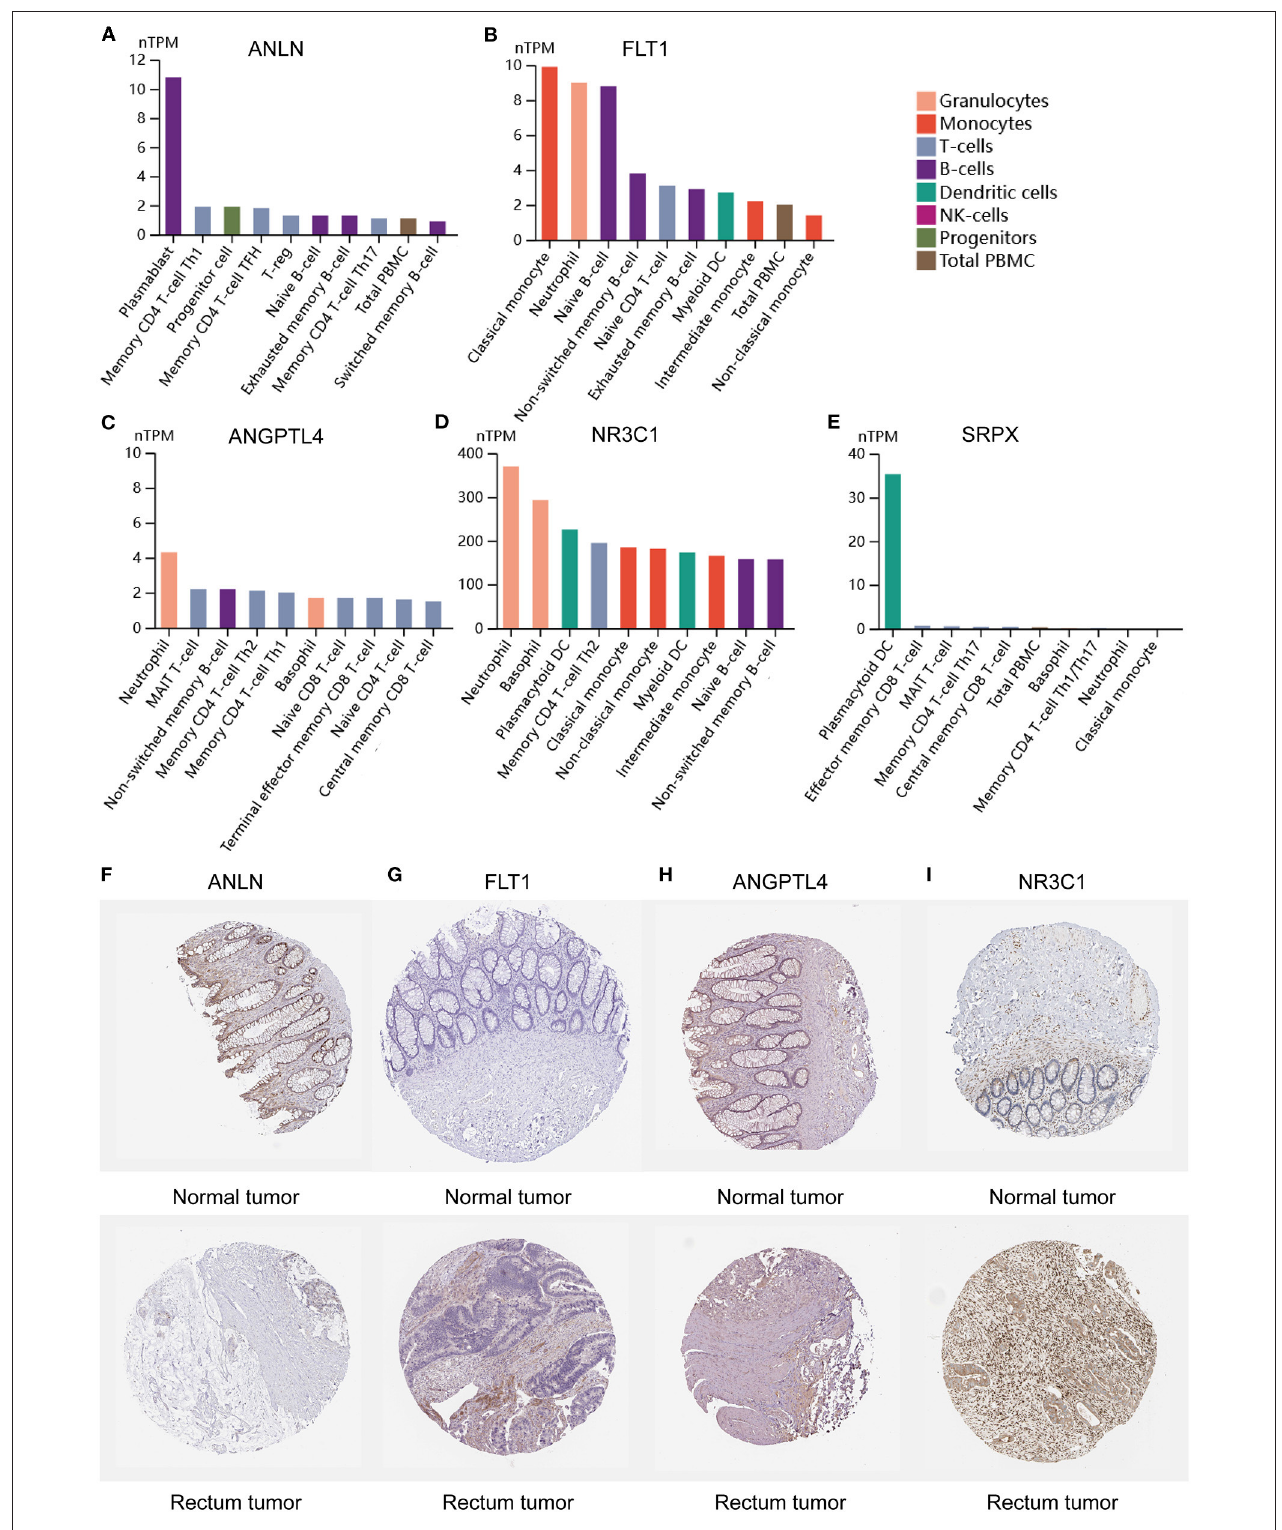
FIGURE 8 | Expression of 5 genes in different immune cell lines and tissues. (A–E) The expression of hub genes in cell types. (F–I) Immunohistochemical staining for the key genes in normal tissues and rectum cancer tissues.